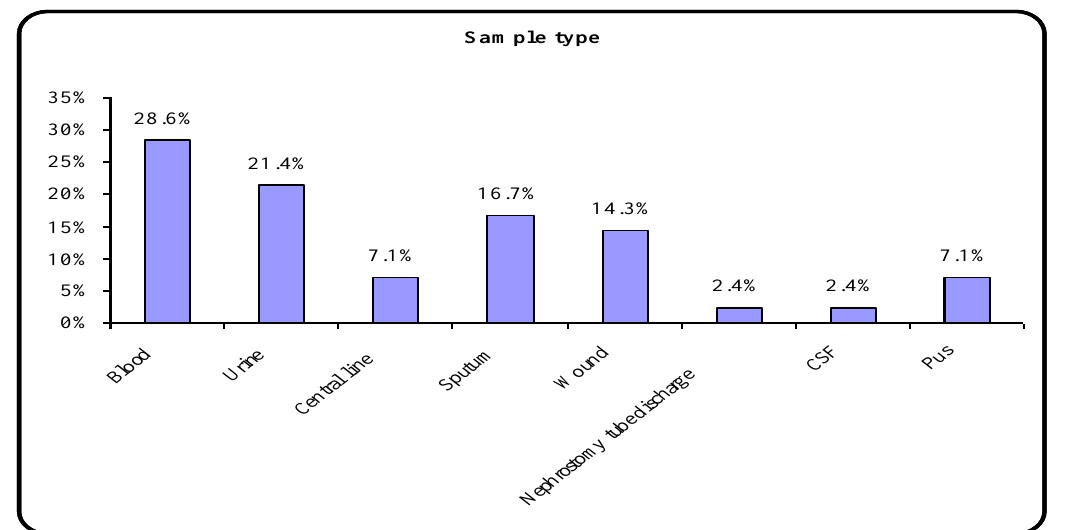
Figure 1. Frequency of clinical samples included in the